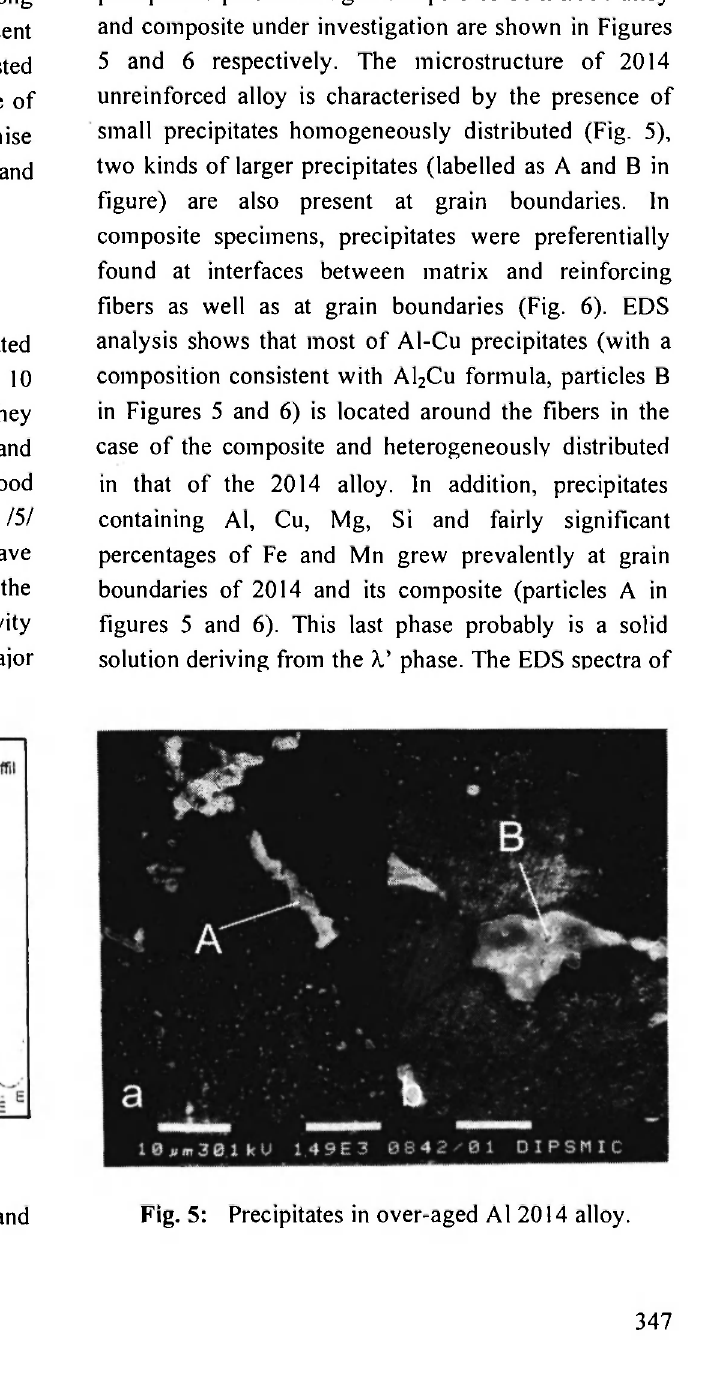
Fig. 5: Precipitates in over-aged Al 2014